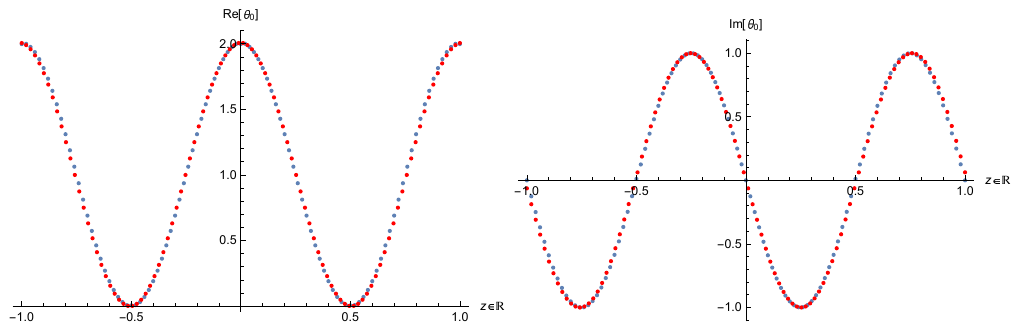
(2 τ +1)+ z ; τ ) for z ∈ [ − 1 , 1] and τ = i. The Figure 3 . The plot of Real and Imaginary parts of θ 0 ( 1 2 blue dots come from the representation (2.8) for m = 2 and n = 1 , truncated at the element j = 100 . The red dots come from the product representation (A.3) truncated at the element j = 20